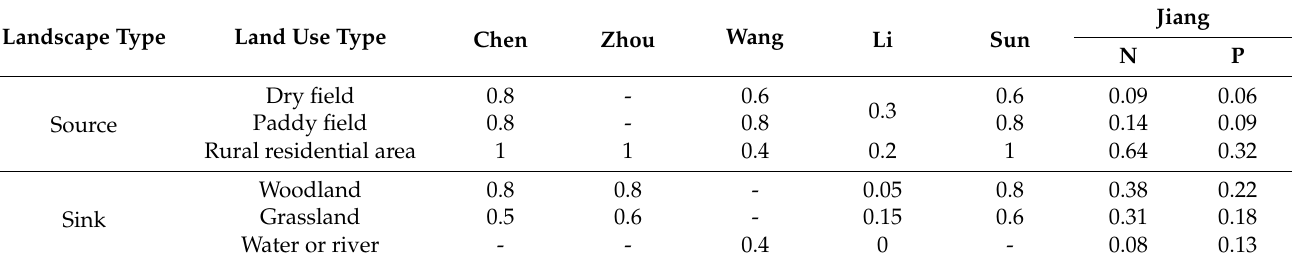
Table 7. Various weight assignment methods used in different